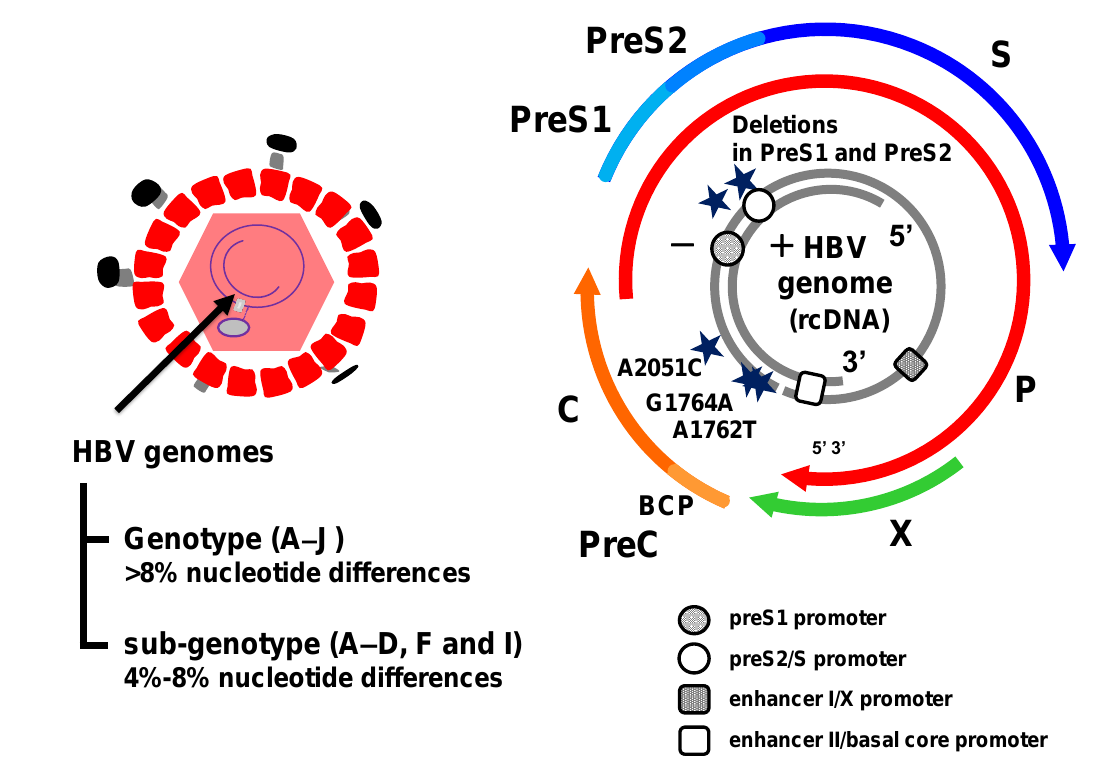
Figure 1. Hepatitis B virus (HBV) mutations associated with hepatocellular carcinoma (HCC). HBV genome and the HBV mutations associated with hepatocarcinogenesis. HBV genotypes (A–J, type I is a subtype of type C) and sub-genotypes (A–D, F, and I) have been classified based on the divergence of the HBV genomes more than 8% and 4%, respectively. The partially double-stranded DNA (dsDNA) encoding four open reading frames (ORFs) and the BCP promoter are shown. ORFs: pre-core/core (preC/C) that encodes the e antigen (HBeAg) and core protein (HBcAg); P for polymerase (reverse transcriptase), PreS1/PreS2/S for surface proteins [three forms of HBsAg, small (S), middle (M), and large (L)] and X for a transcriptional trans-activator protein. The preS1 and preS2/S promoter regions are denoted by the rounds. The enhancer I/X promoter and enhancer II/basal core promoter regions are denoted by the